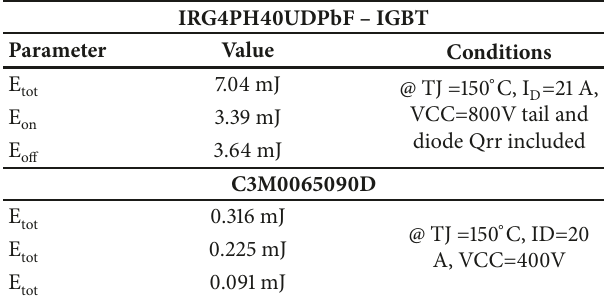
Table 4: Switches data used for the cycle-by-cycle switching loss